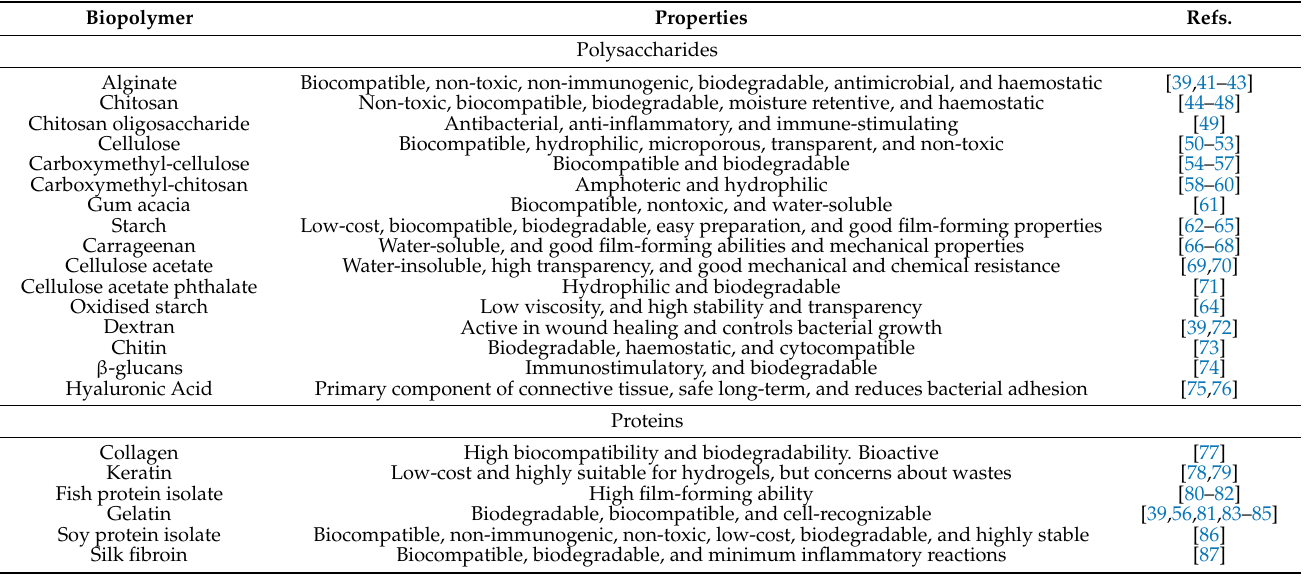
Table 1. Overview of biomacromolecules for wound dressing